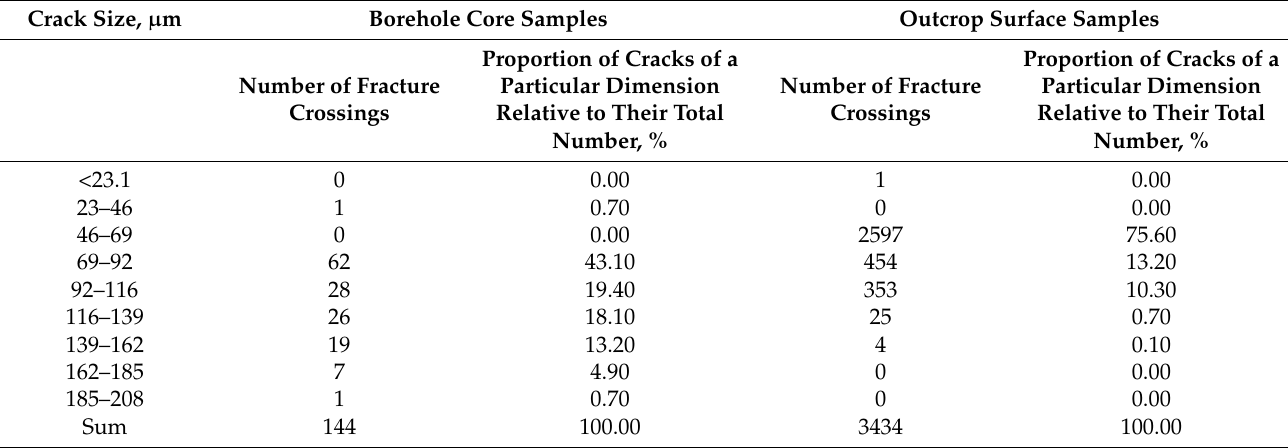
Table 3. Results of crack measurement and calculation in dolomitic limestone samples according to 3D X-ray tomography. Crack Size, µ